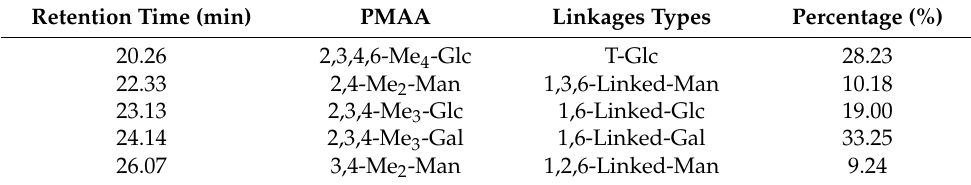
Table 2. GC-MS date for methylation analysis of CHFVP-1.